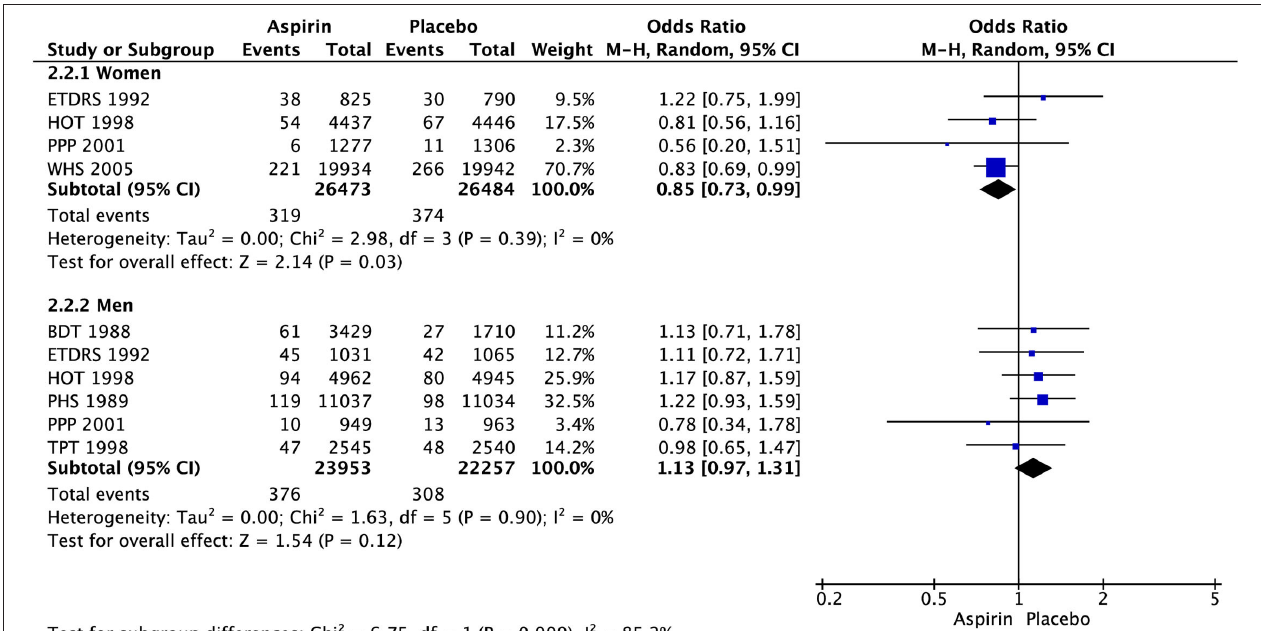
FIGURE 3 | Stroke in women and men taking aspirin or placebo.